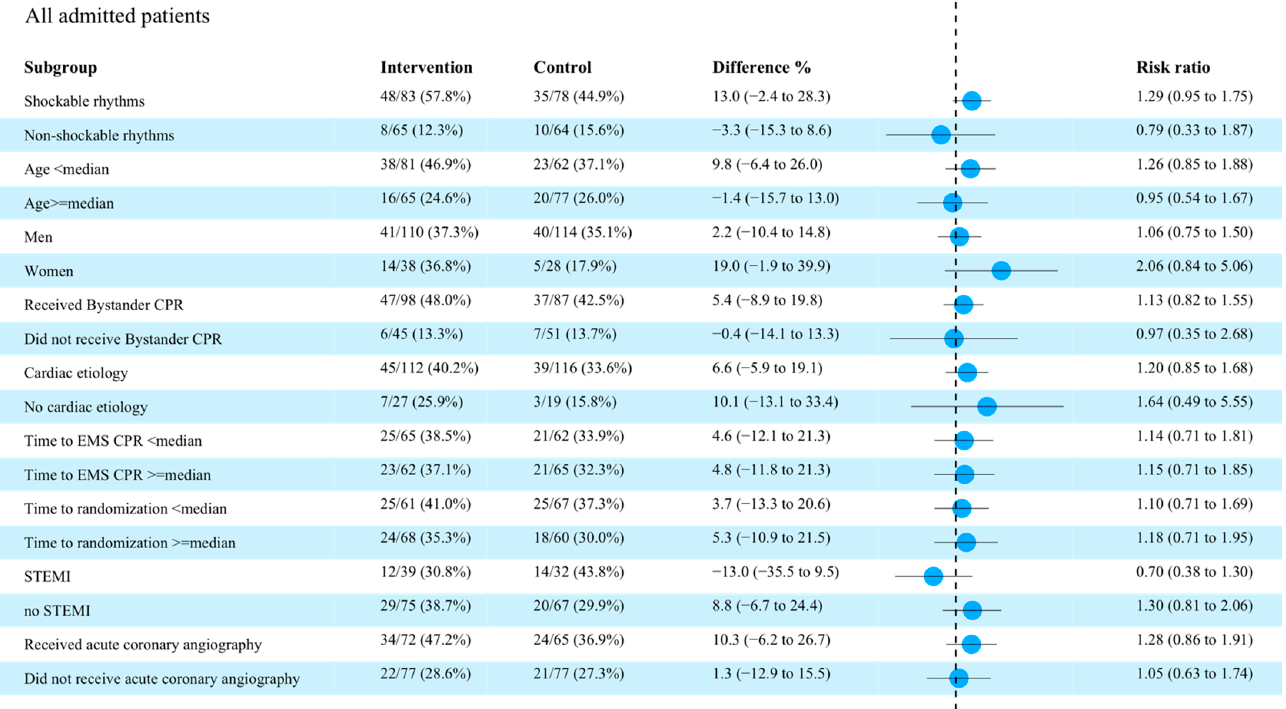
Figure 1. Forest plot for all patients admitted alive to hospital. CPR = cardiopulmonary resuscitation; EMS = emergency medicine system; STEMI = ST-elevation myocardial infarction.